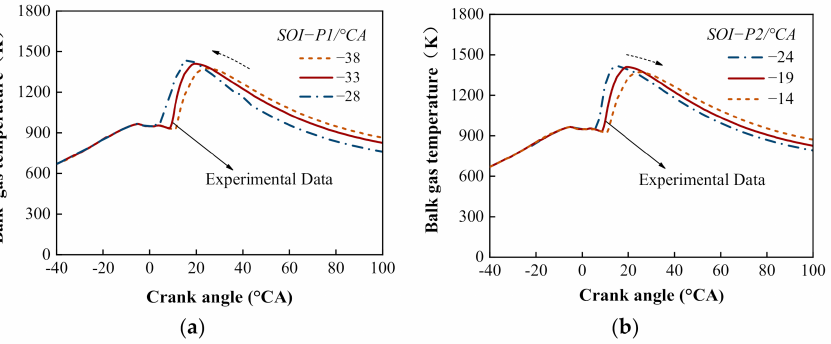
Figure 6. Bulk gas temperature in cylinder: ( a ) adaptation of SOI − P1 ; ( b ) adaptation of SOI − P2